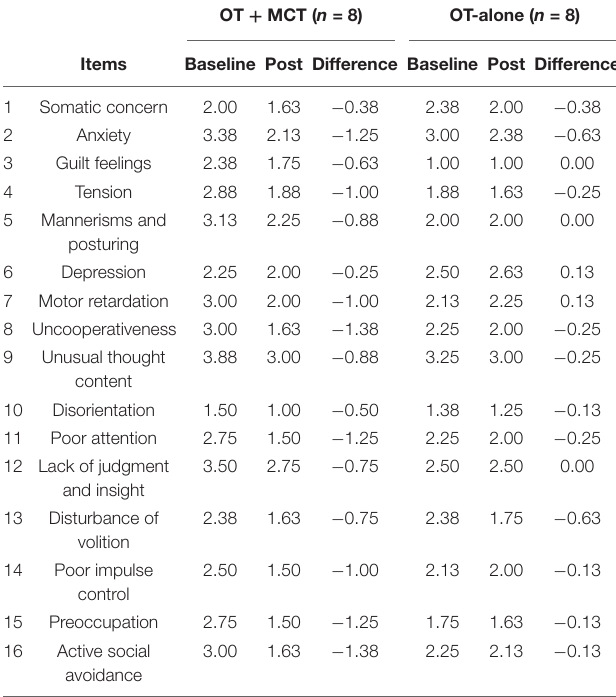
TABLE 3 | Changes in the mean of the general psychopathology scale of PANSS. OT + MCT ( n =